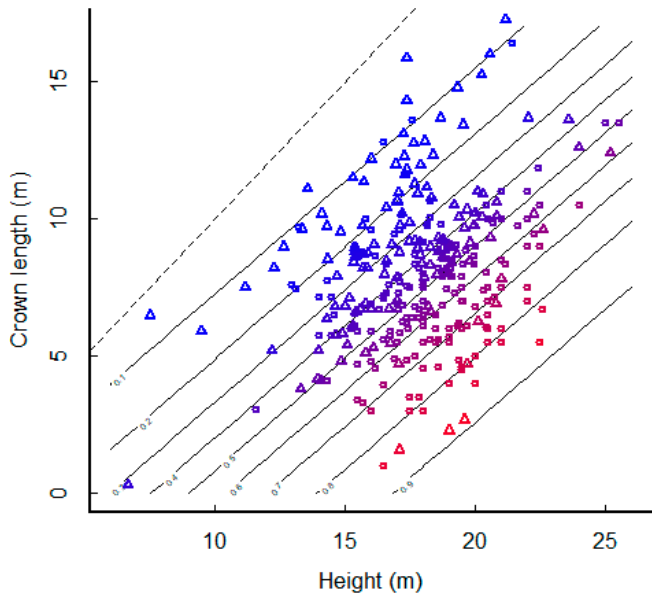
Figure 4. Probability of mortality (symbol colour, from blue = low to red = high) as a function of tree height and crown length. Labelled contour lines also show the probability at each combination of crown length and height. Each point is a measured stem: squares = dead, triangles = live. All other variables are held at their mean values.